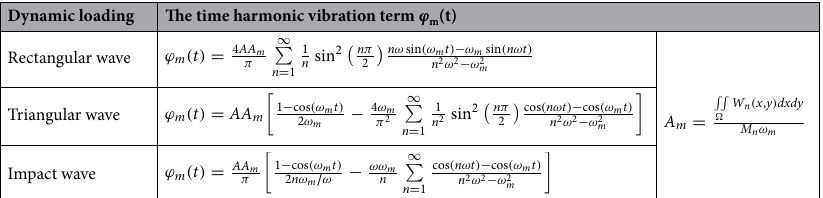
Dynamic loading The time harmonic vibration term φ m (t) Rectangular